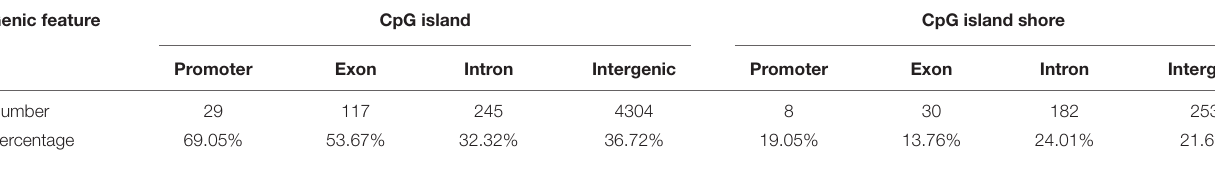
TABLE 2 | DMCs associated with CpG island regions located at different genic